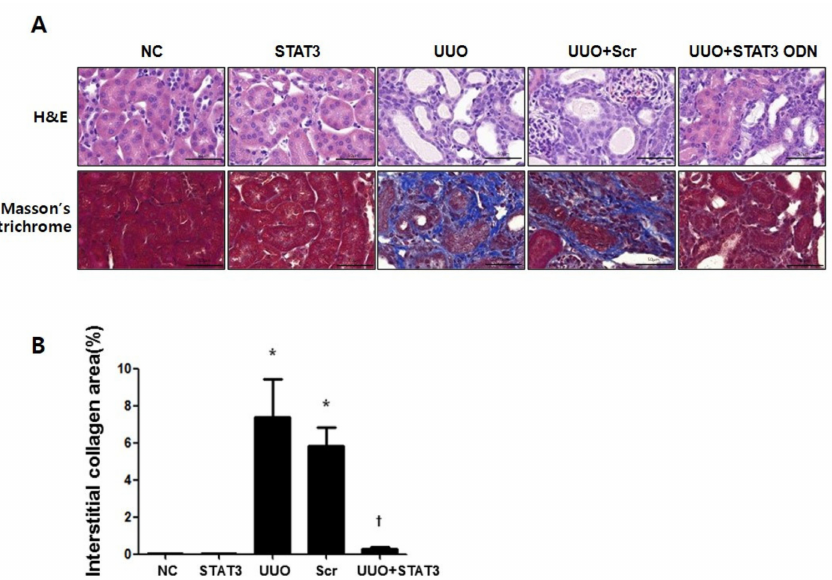
Figure 1. Reduction in Renal Interstitial Injury and Fibrosis in UUO Mouse Kidneys due to STAT3 Decoy ODNs. The effects of STAT3 decoy ODNs on histological alterations after UUO. ( A ) The kidney sections stained with hematoxylin and eosin (H&E) stain and the Masson’s trichrome stain. ( B ) Quantitative analysis of the interstitial collagen area of each group ( n = 3) and performed at a magnification of 400X. The results are expressed as means ± SE of three independent determinations * p < 0.05 vs. NC, † p < 0.05 vs. UUO; NC, normal control group; STAT3, STAT3 decoy injection to normal control group; UUO, UUO surgery group; Scr, scramble ODN injection to UUO surgery group; UUO + STAT3, STAT3 decoy ODN injection to UUO surgery group. Abbreviations: UUO, unilateral ureteral obstruction; decoy ODNs, decoy oligonucleotides; STAT3, signal transducer and activator of transcription 3; Scr,